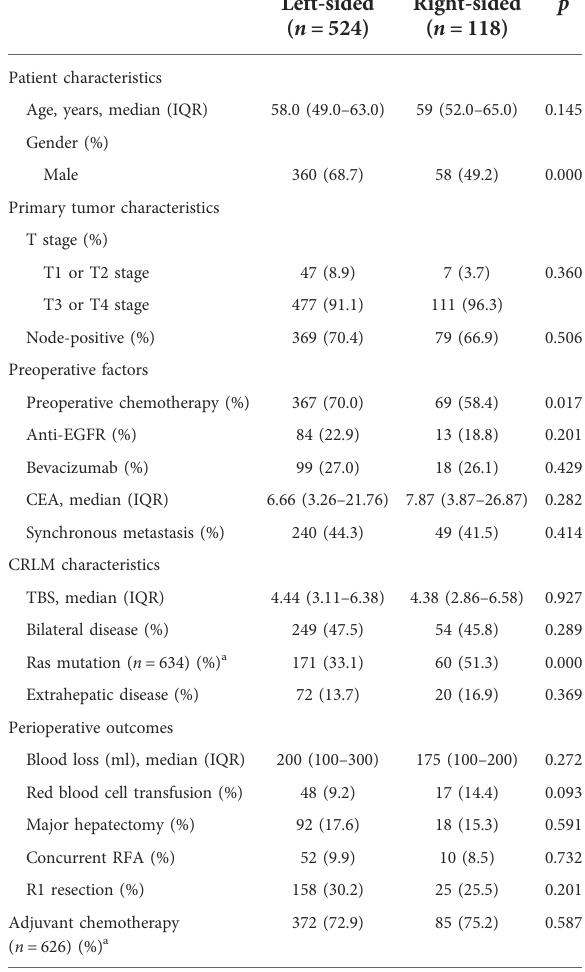
TABLE 1 Clinical, pathological and molecular characteristics strati fi ed according to PTL ( N